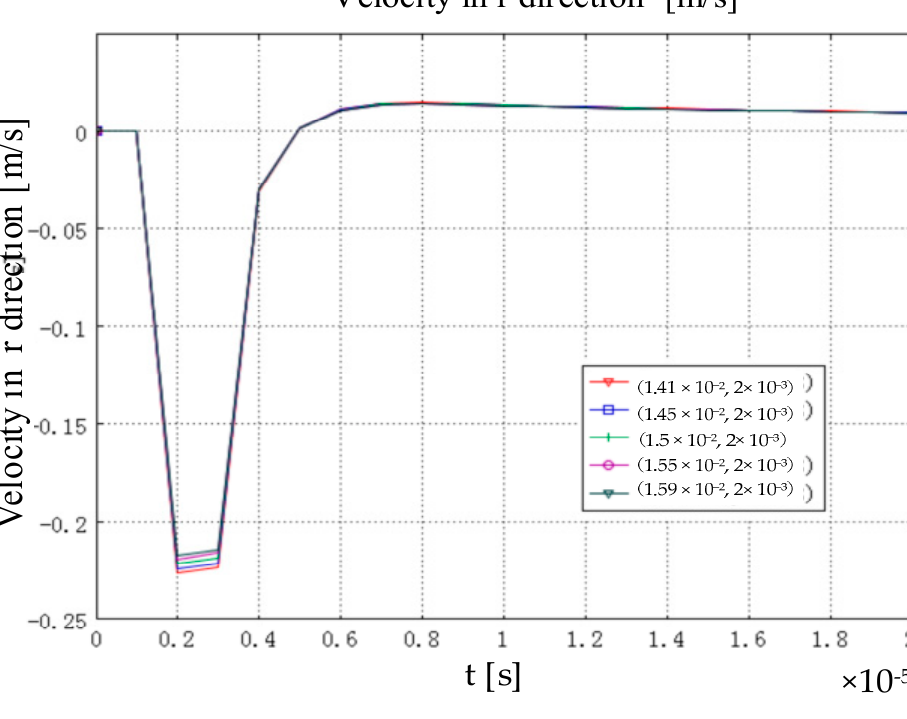
Figure 5. Lorentz force in z direction.